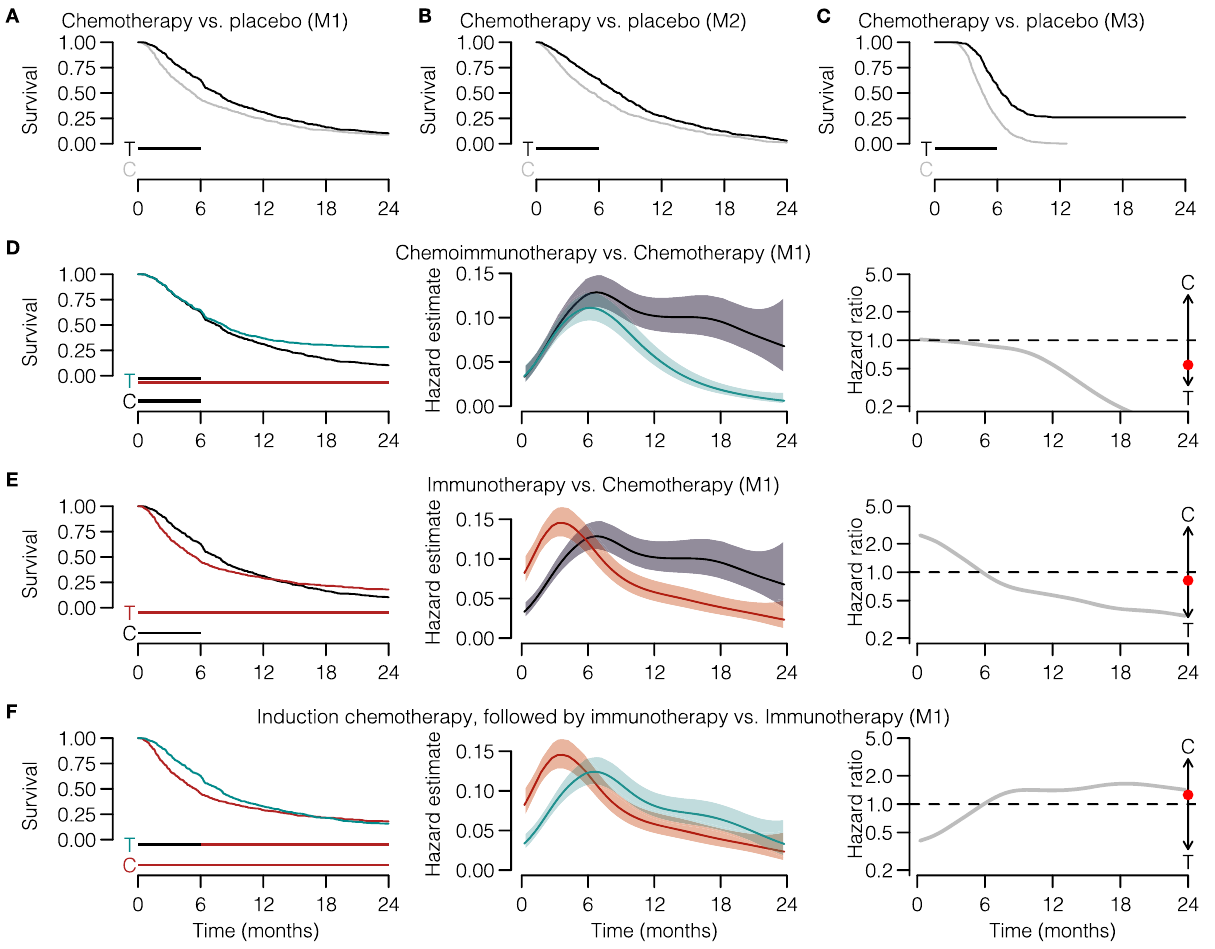
Fig. 4 | In silico clinical trials can predict immunotherapy-speci fi c survival patternsbasedonbiologicalassumptions.A – F Examplesof1:1randomizedtrials with various (treatment) regimens ( n =600 simulated patients per arm). A – C A traditionalchemotherapytrial(vs.placebo)onlyshowsaproportionalhazardratio when the biological treatment effect targets the tumor directly and remains con- stant over time (compare to Supplementary Fig. 2). D An in silico immunotherapy trial elicits typical immunotherapy-induced survival curve shapes (i.e., delayed curve separation) and violates the proportional hazard assumption. E , F More intricate treatment or control regimens – ( D ) immunotherapy+chemotherapy-